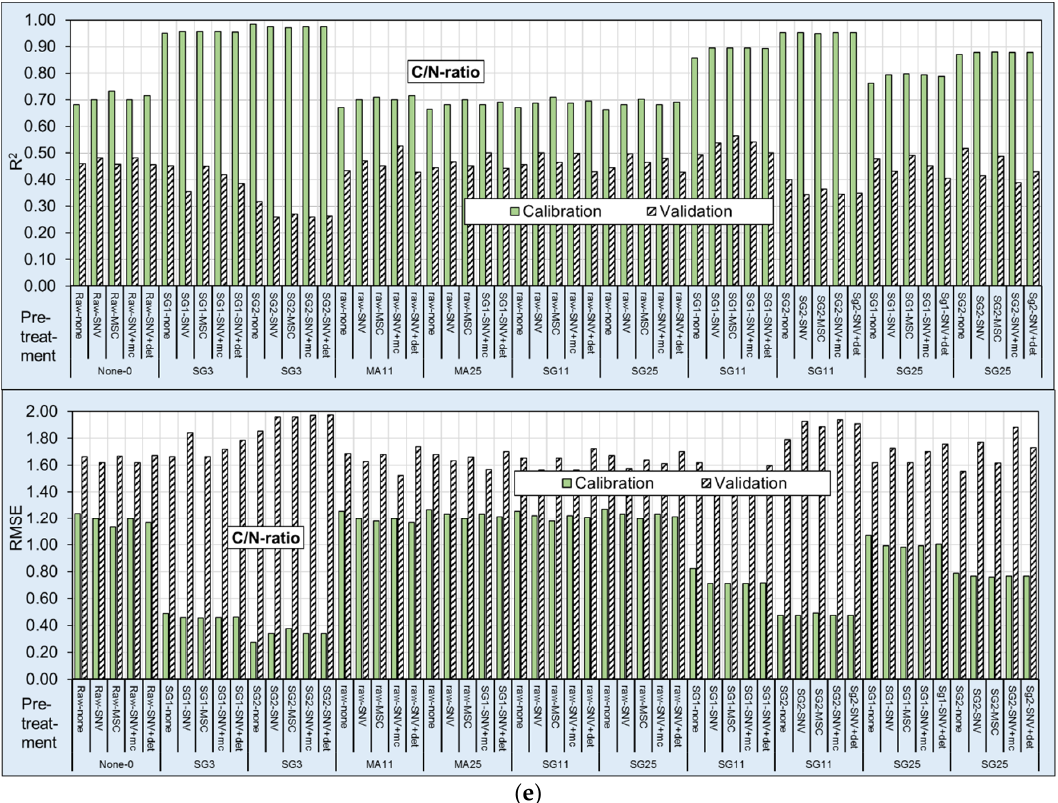
Figure 6. Indices for calculations with partial least squares regression (PLSR) R 2 and root mean square error (RMSE) for all applied pre-treatments; ( a ) Ct, ( b ) Corg, ( c ) Ccal, ( d ) N, ( e ) C/N. For abbreviations, see Table 3.